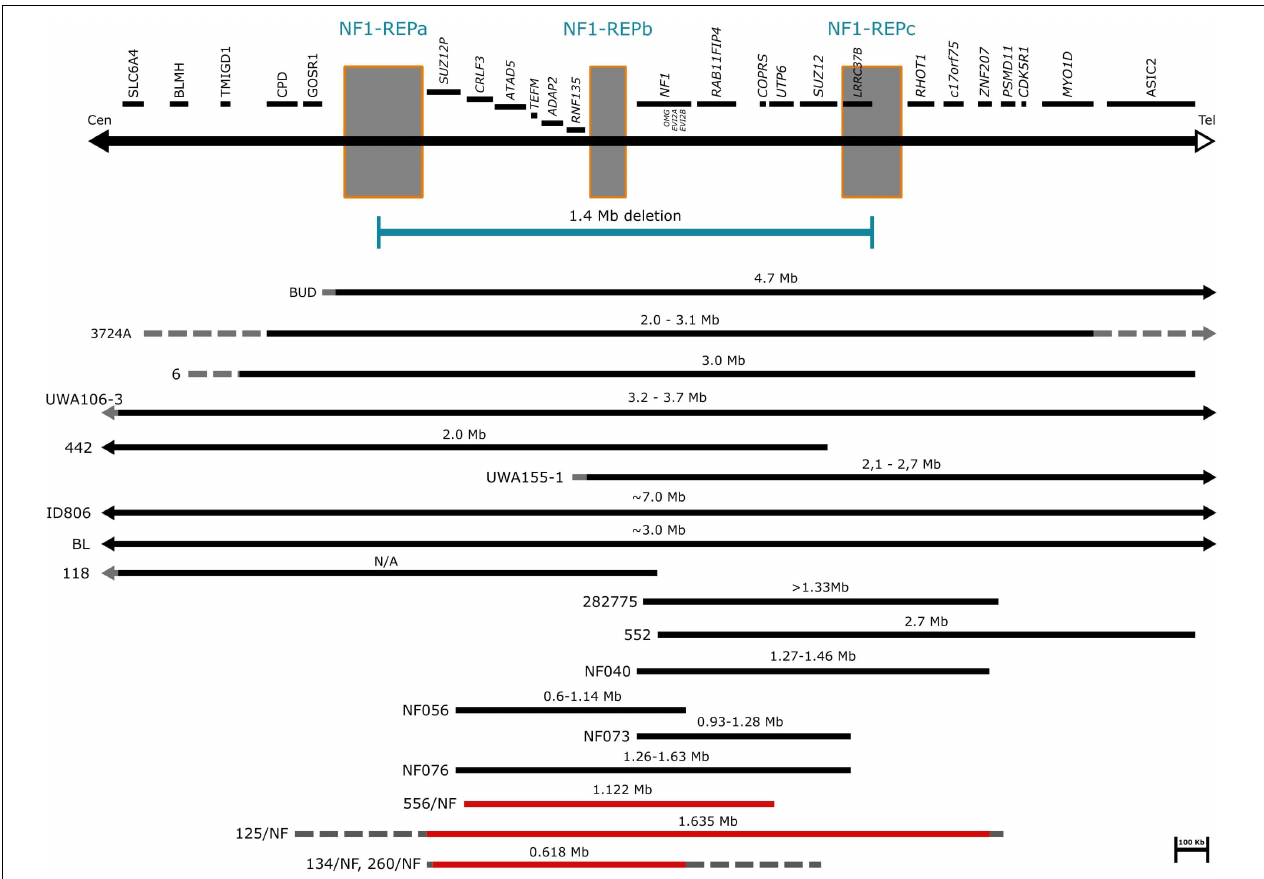
FIGURE 2 | Schematic representation of atypical NF1 deletions. The affected genes and NF1-REP regions schematically are displayed at the top of the figure. Horizontal black bars represent the already known atypical NF1 cases. Solid lines indicate the deleted regions, dotted lines indicate the possibly deleted regions. Horizontal red bars refer to our cases. Solid lines represent the deleted regions, while dotted lines suggest the potential deletion